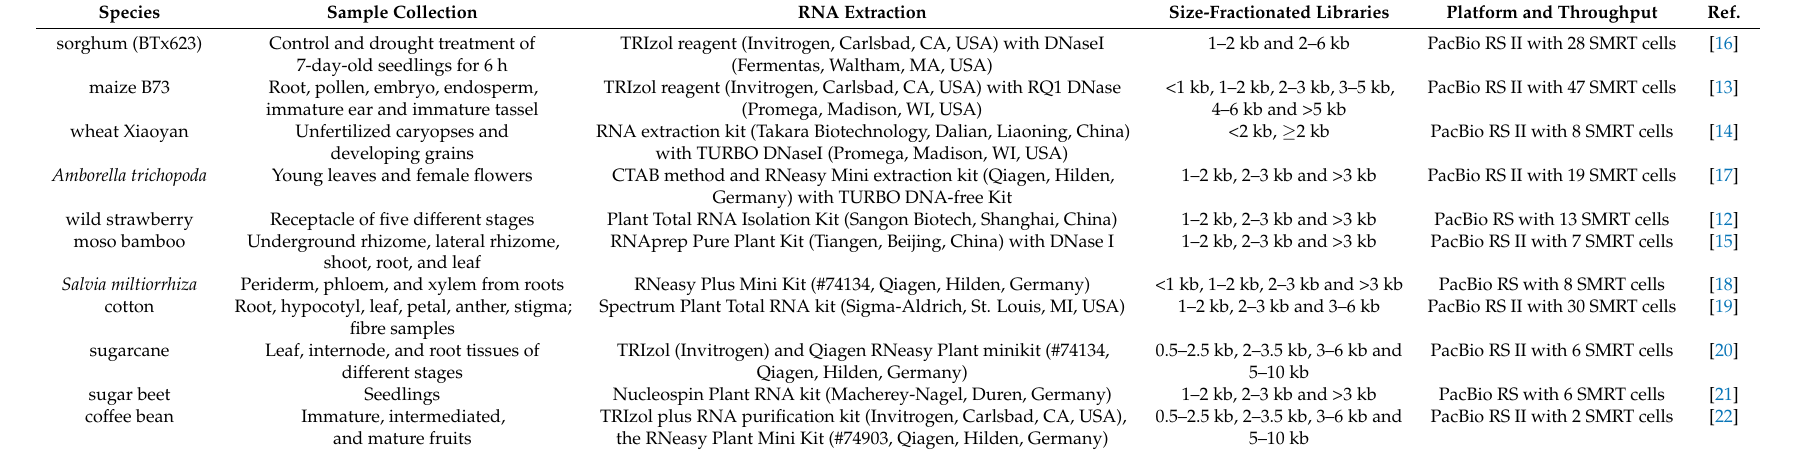
Table 1. Summary of sample collection, RNA extraction, library construction, sequencing platform, and throughput for isoform sequencing in